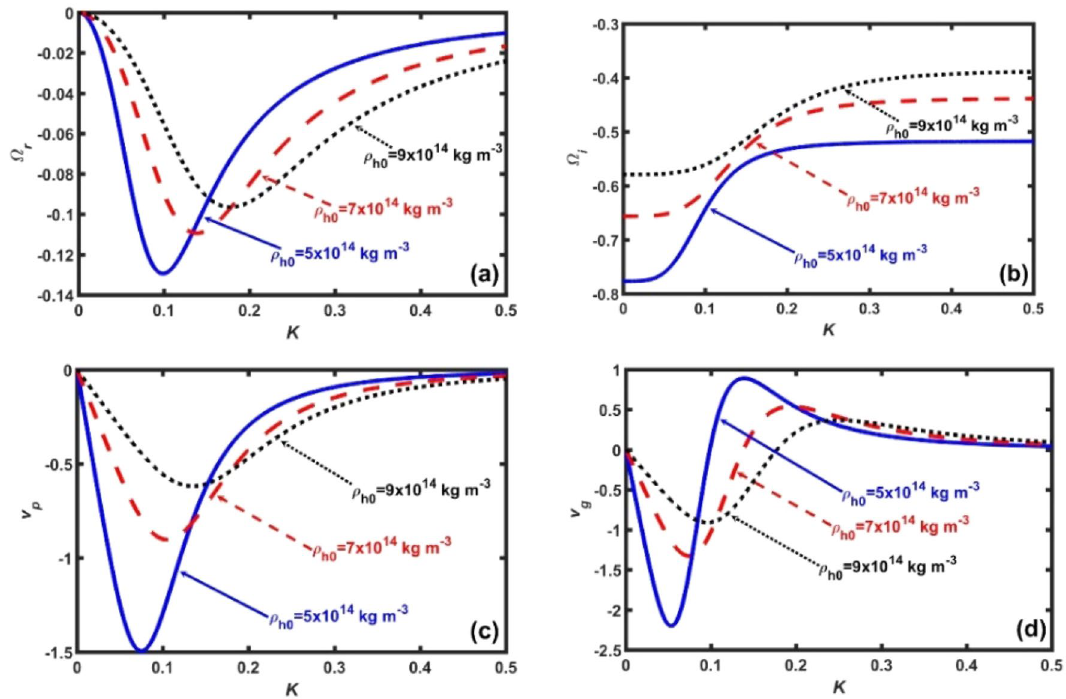
Figure 1. Profile of the Jeans-normalized ( a ) real frequency (� r ) , ( b ) imaginary frequency (� i ) , ( c ) phase velocity ( v p ) , and ( d ) group velocity ( v g ) of the fluctuations with variation in the Jeans-normalized wavenumber ( K ) for the different ρ h 0 -values. The distinct lines link to ρ h 0